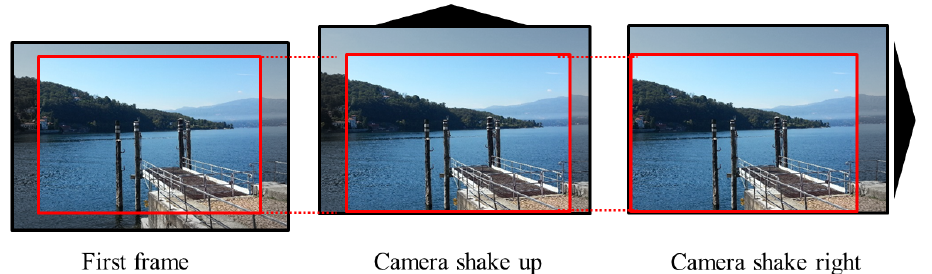
Figure 1. Digital motion video stabilization on subsequent frames. Undesired camera shakes are compensated for in order to have stable